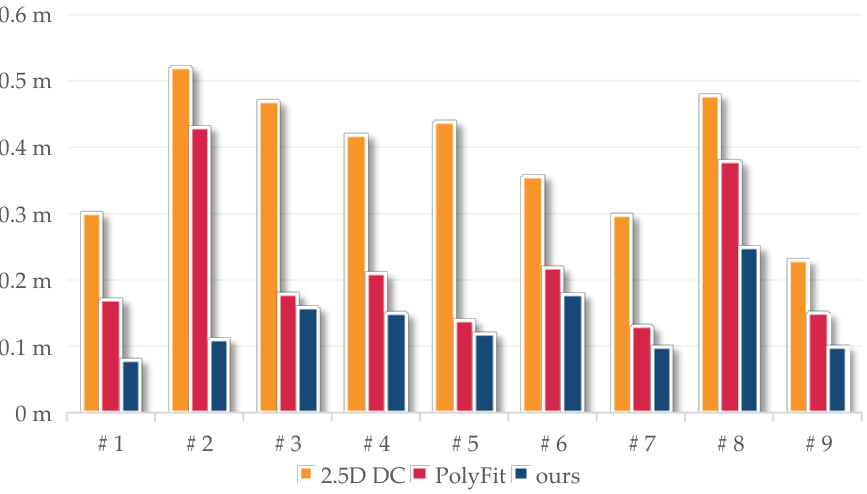
Figure 18. The RMSE m2m of nine building models generated using 2.5D DC, PolyFit, and our proposed method.